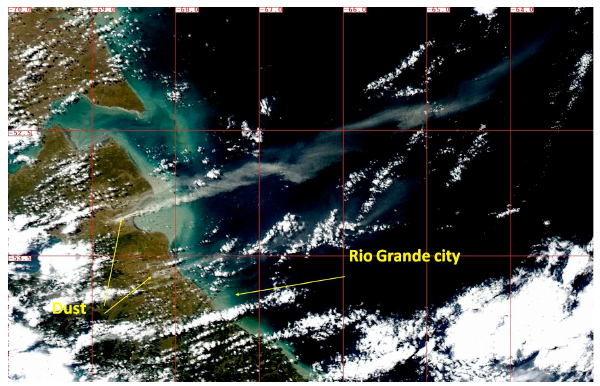
Fig. 2. Dust Event in the Tierra del Fuego Island ( ∼ 53S) detected Figure 2: Dust Event in the Tierra del Fuego Island (~53S) detected by MODIS in by MODIS in the Aqua satellite on 26 February 2005. The largest the Aqua satellite on February 26, 2005. The largest plume is in the Gulf of San Sebastian and several minor plumes (some are not resolved in this image but they plume is in the Gulf of San Sebastian and several minor plumes are visible by zooming in the full 250 m image) are located between San Sebastian (some are not resolved in this image but they are visible by zooming and the city of Rio Grande, 100 km south. in the full 250m image) are located between San Sebastian and the city of Rio Grande, 100km